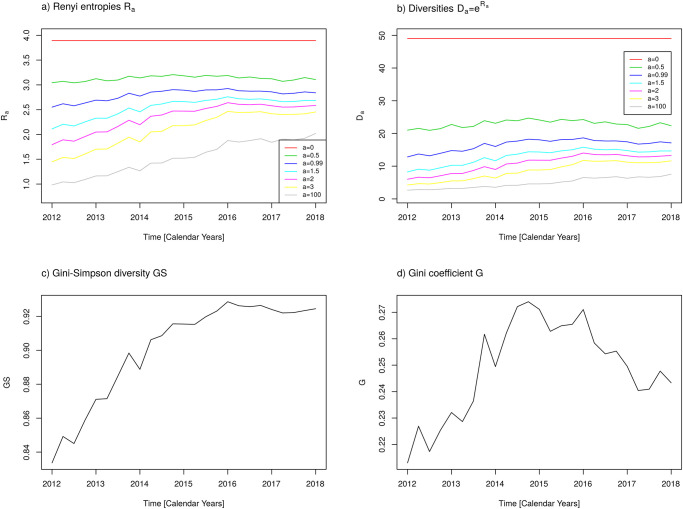
Diversity measures with respect to active agents.a) Renyi entropies Ra for a = 0, 0.5, 0.99, 1.5, 2, 3, 100, b) Diversities Da for a = 0, 0.5, 0.99, 1.5, 2, 3, 100, c) Gini-Simpson index GS, d) Gini coefficient G.